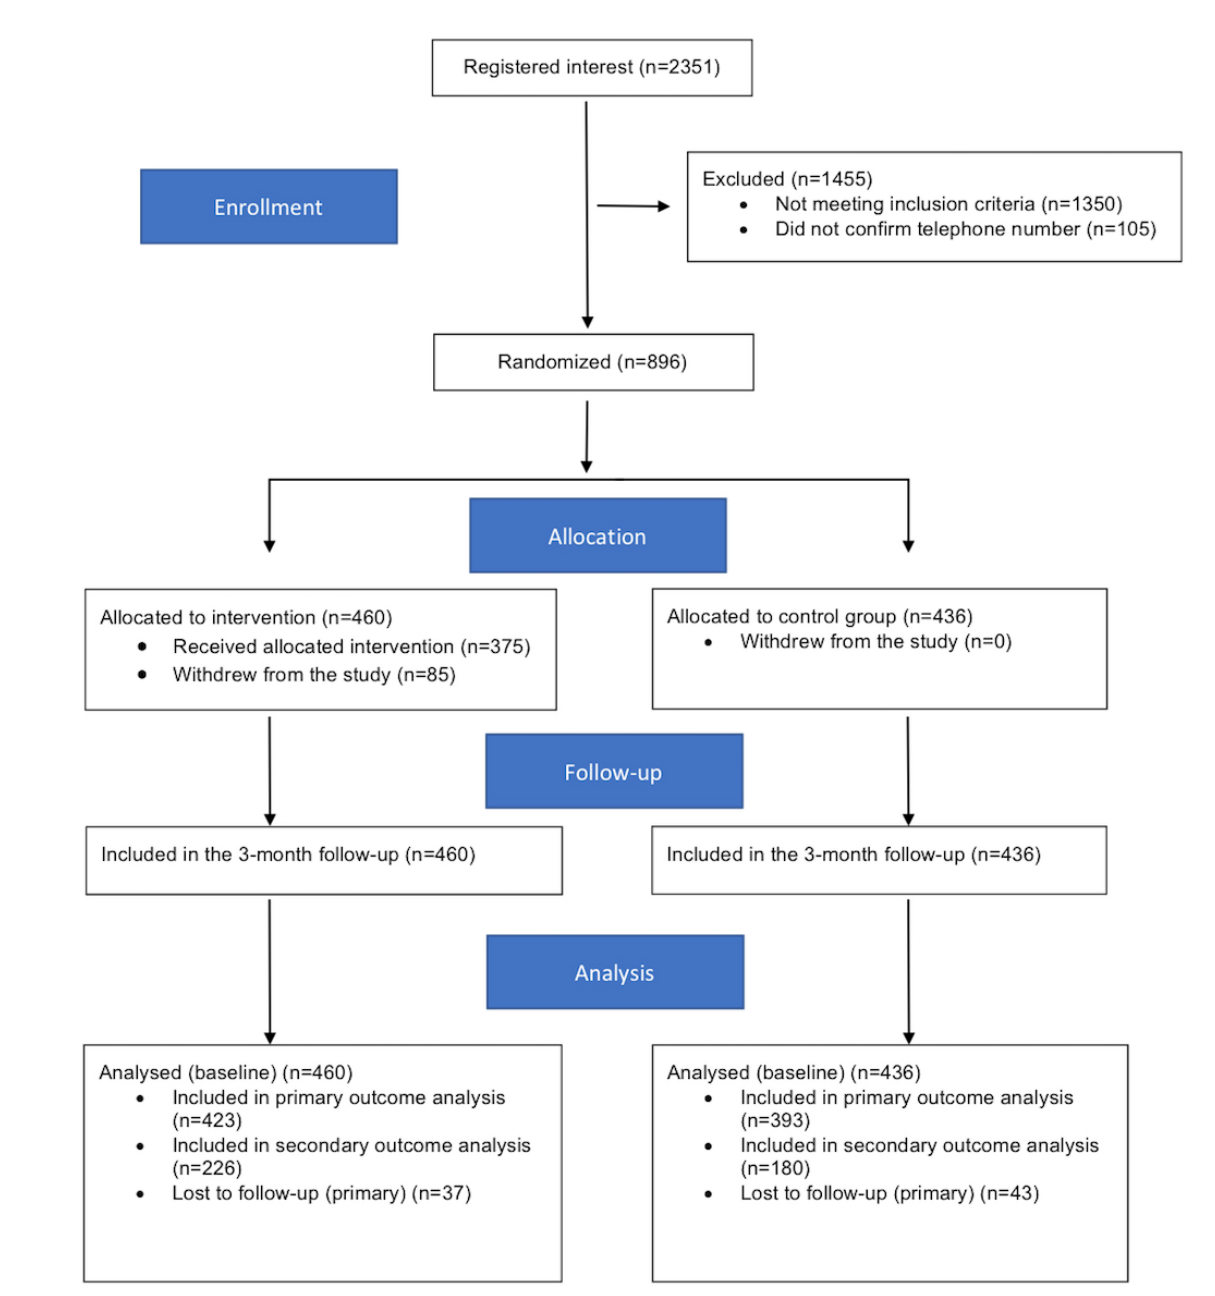
Figure 1. The Consolidated Standards of Reporting Trials (CONSORT) 2010 flow